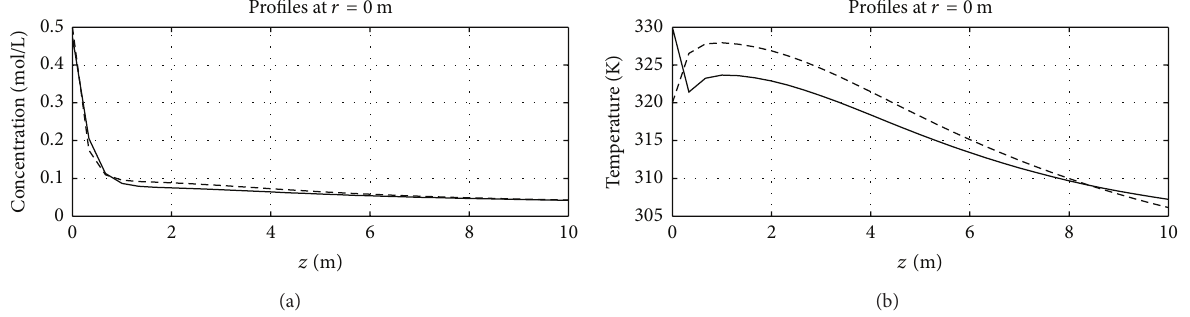
Figure 16: Steady state temperature and concentration profiles for Test 2 at 𝑟 = 0 m. Solid line—MPC. Dashed line—nominal profile (reference).